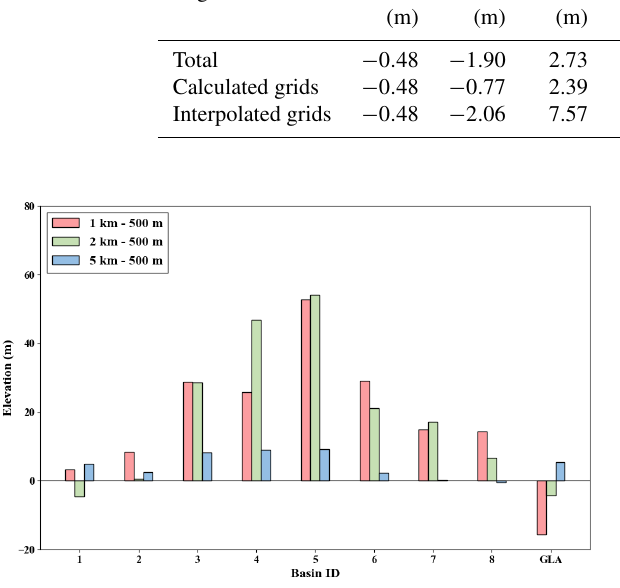
Figure 5. Elevation differences of nine main regions under different resolutions, which are calculated by subtracting the 500m DEM from the 1, 2, and 5km DEMs through the overlapping grids of different DEMs. The color bar shows the mean elevation differences of these regions.